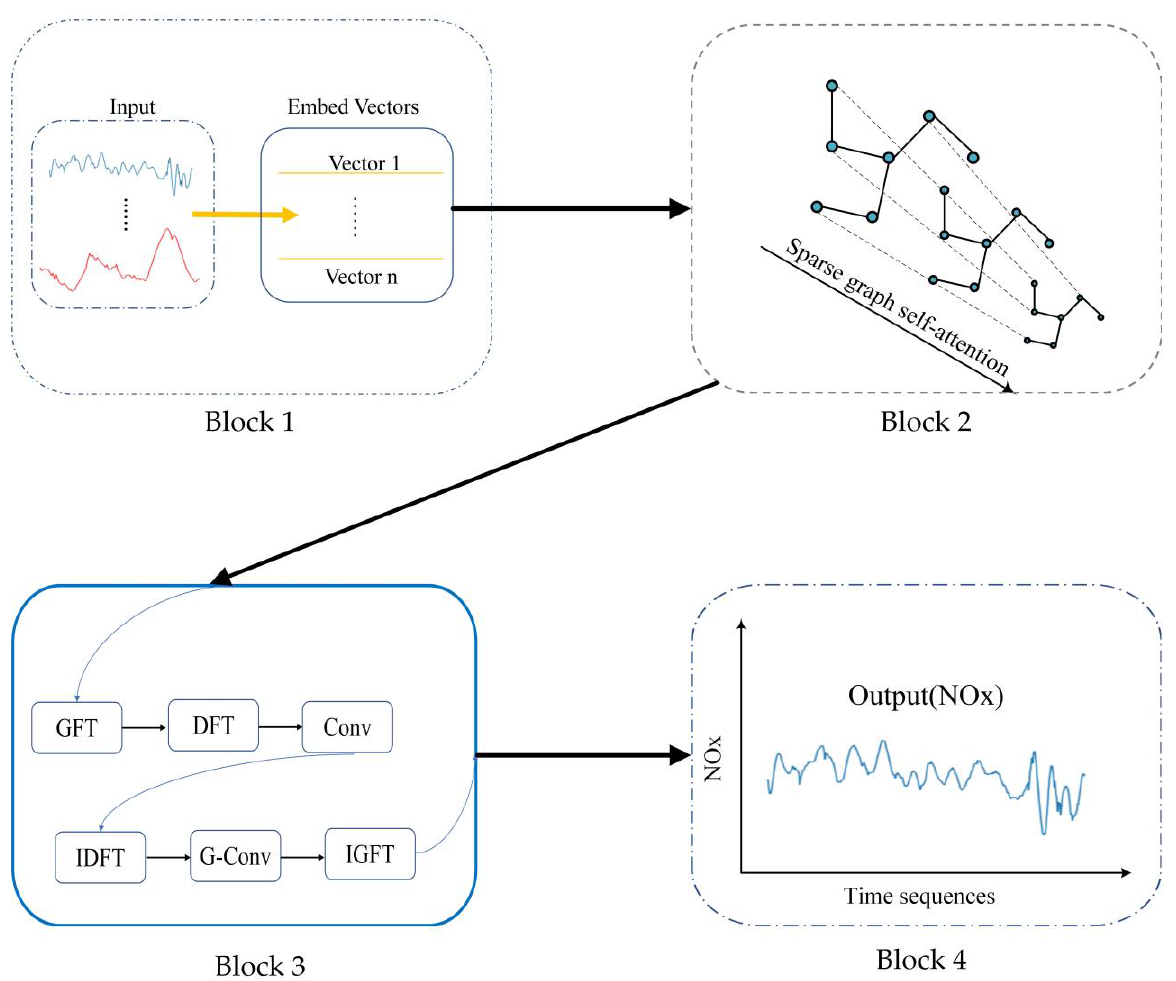
Figure 1. Schematic diagram of EGNN consisting of four blocks: multidimensional variable embed- ding, sparse graph self-attention mechanism, graph neural network based on Fourier transform and output block.